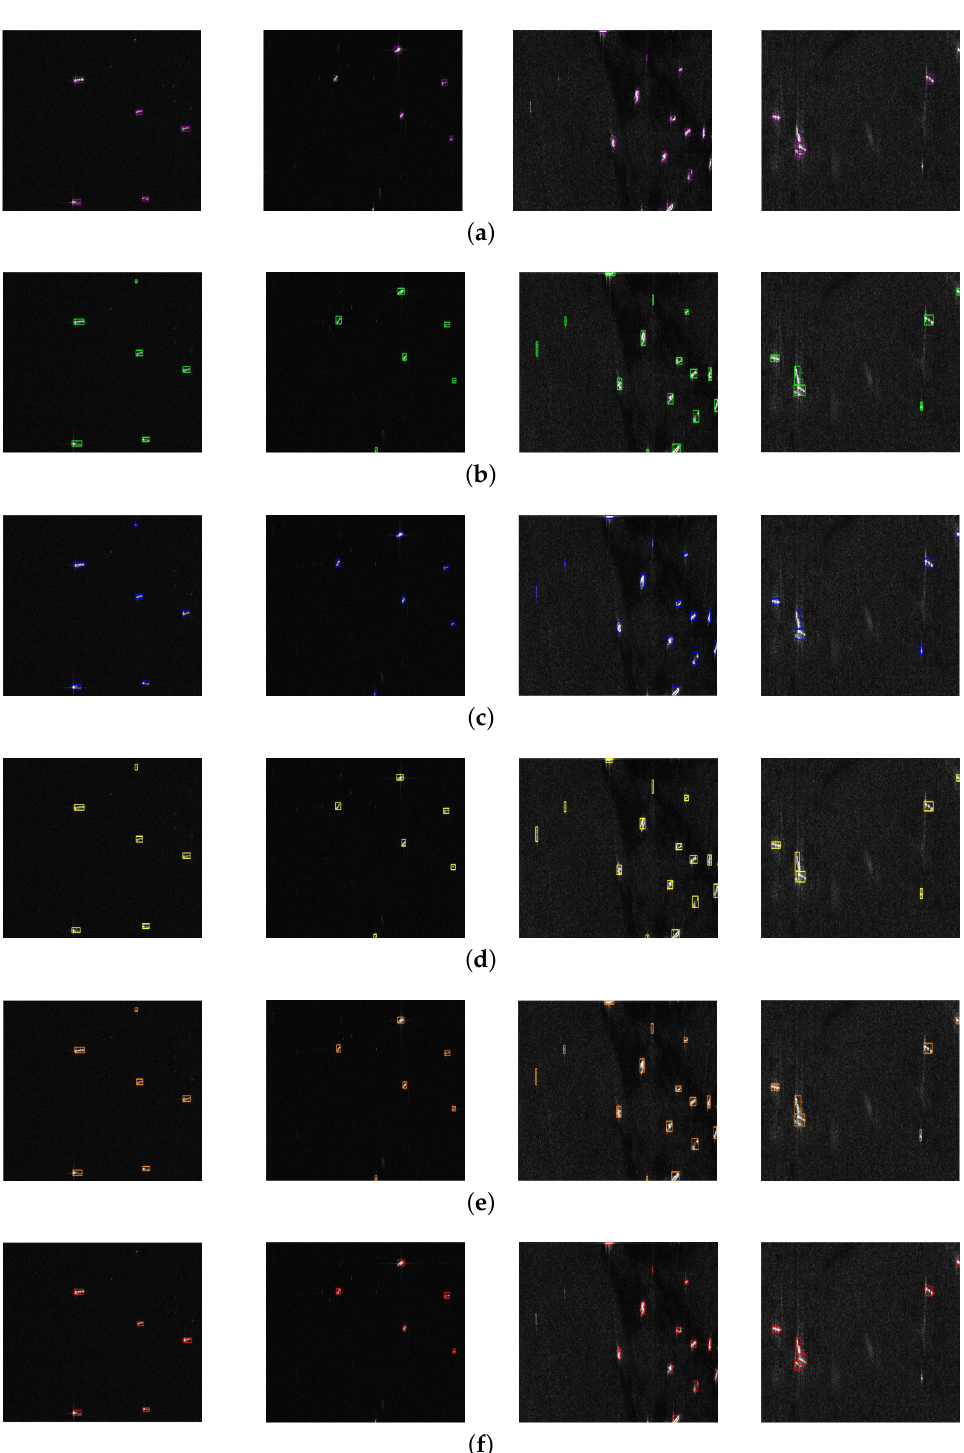
Figure 12. Detection results of different methods on offshore images. ( a ) Ground truth; ( b ) Cascade RCNN; ( c ) DCN; ( d ) Guide anchoring; ( e ) PAFPN; ( f )